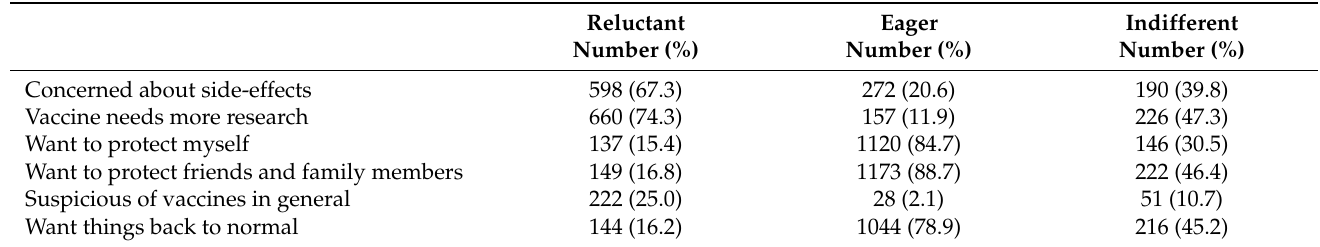
Table 4. Reasons for eagerness or reluctance to vaccinate among students in Nevada, February–